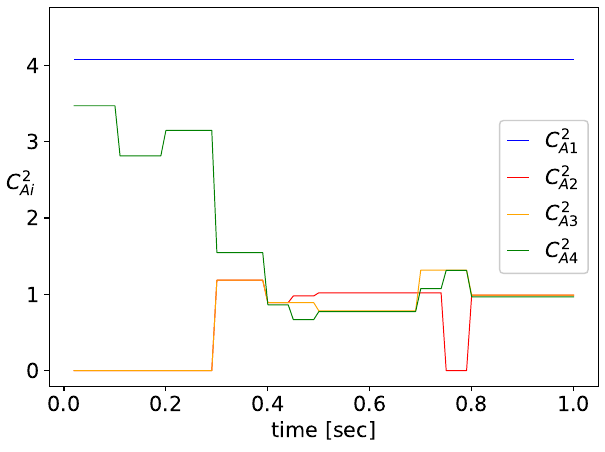
( t ) for stations S 1 ... S Ai